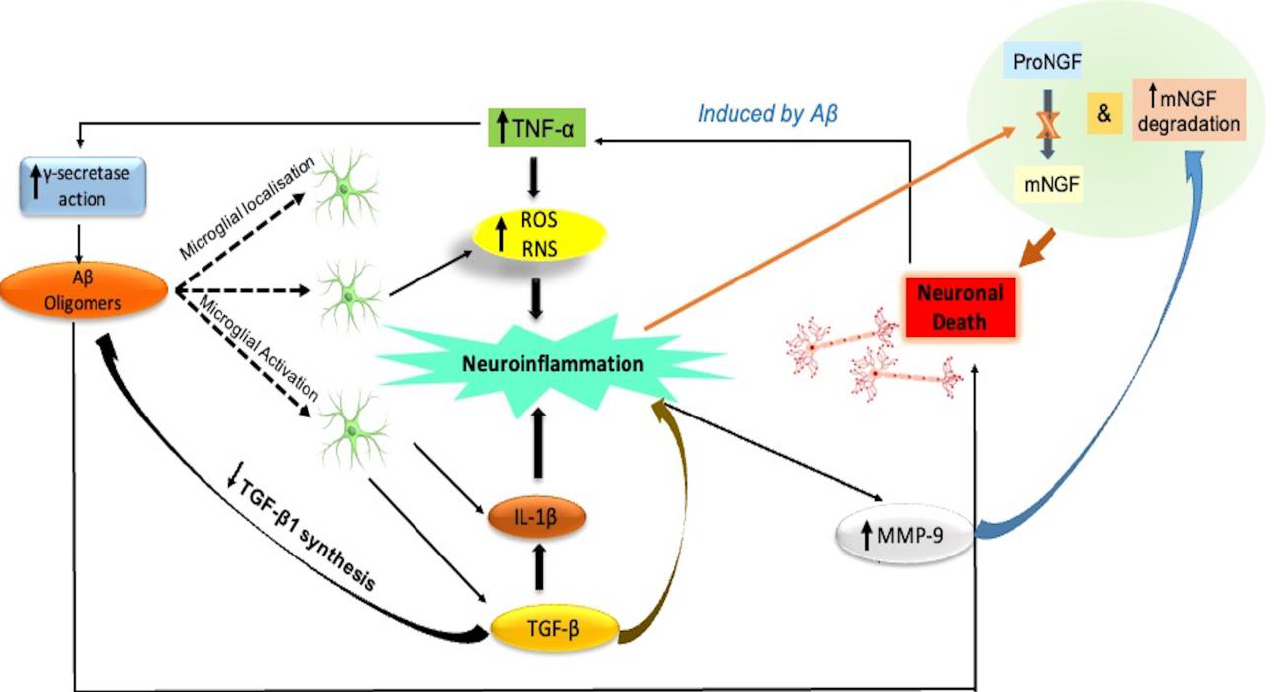
Figure 3. Neuroinflammation: A key initiating component in the development of AD. Signaling of neurotrophins is impaired. By inducing microglia to release proinflammatory cytokines (IL- 1 β and TNF- α ) and blocking the production of anti-inflammatory cytokines such as TGF- β 1, A β oligomers cause neuroinflammation and neuronal death in the AD brain. TNF- α promotes g-secretase activity and prevents microglia from phagocytizing A β , which promotes A β build up and microglia- mediated neuroinflammation. Through the production of ROS and RNS, proinflammatory microglial activities also accelerate the death of neurons. Eventually, neuroinflammatory phenomena may play a role in the pathogenesis of AD by impairing neurotrophin signaling. This includes decreasing the synthesis of TGF- β 1 and impairing the NGF metabolic pathway, which is characterized by a decreased conversion of proNGF to biologically active mNGF and a higher rate of mNGF degradation aided by MMP-9. A β , amyloid beta; IL-1b, interleukin-1 beta; MMP-9, metalloprotease-9; NGF, nerve growth factor; mNGF, mature nerve growth factor; proNGF, precursor of the nerve growth factor; RNS, reactive nitrogen species; ROS, reactive oxygen species; TGF- β , transforming growth factor-beta; TNF- α , tumor necrosis